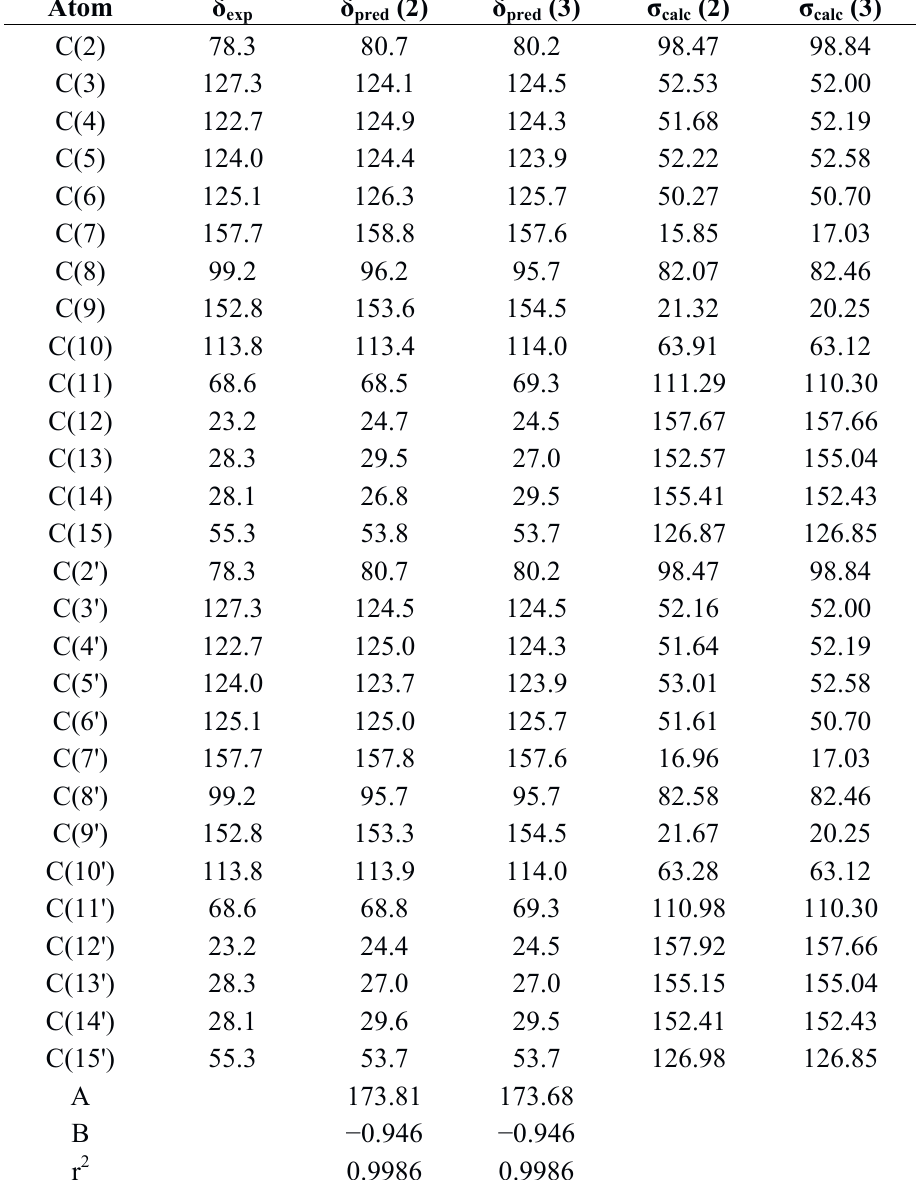
Table 4. Carbon-13 chemical shifts ( δ , ppm) in CDCl and calculated GIAO nuclear 3 ) for ( − )-encecanescin ( 1 ). The predicted GIAO chemical shifts magnetic shielding ( σ cal were computed from the linear equation δ = a + b· σ with a and b determined from the exp calc fit to the experimental data